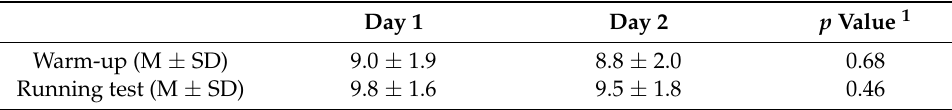
Table 2. Rate of perceived exertion (RPE) differences between sessions at warm-up and the run- ning